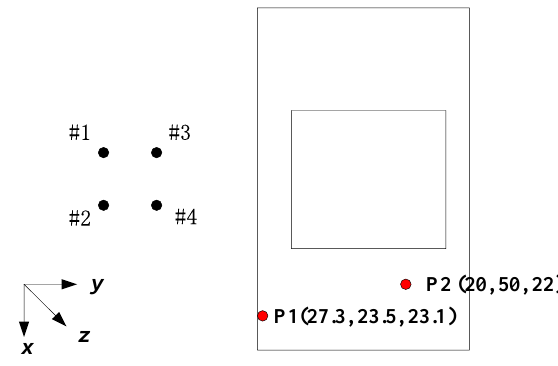
Figure 8. Experimental setup. #1 – #4 are the antennas #1 – #4.